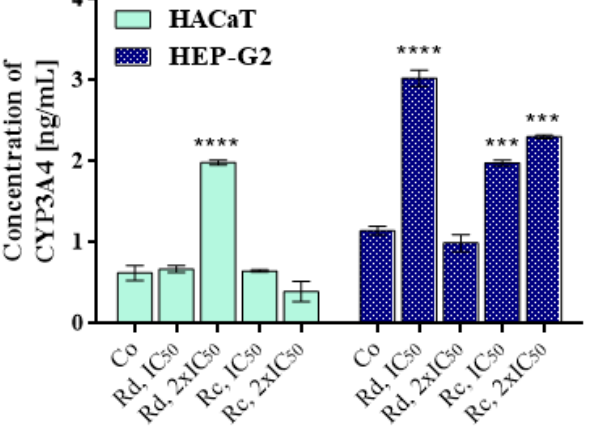
Figure 4. Effects of wastewaters obtained from Rosa damascena Mill. and Rosa centifolia L. on the concentration of the enzyme CYP3A4. Legend: Co: control; Rd: R. damascena Mill.; Rc: R. centifolia L.; IC 50 : median inhibitory concentration for 72 h (see Table 3). Significant deviations from the untreated controls are denoted with asterisks (*** for p < 0.001, **** for p < 0.0001).